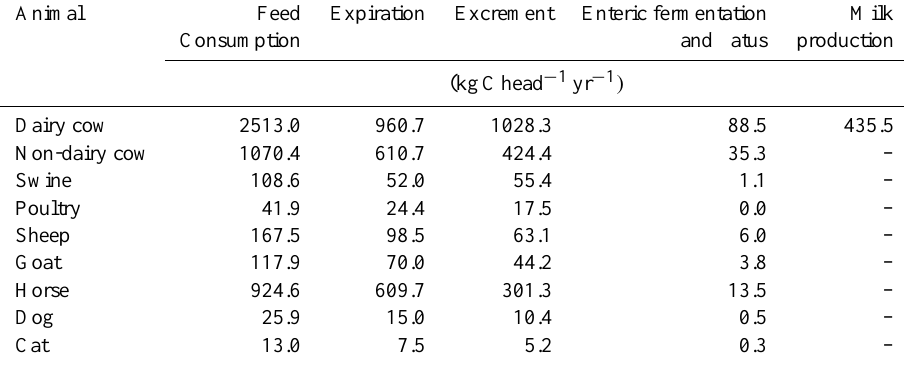
Animal Feed Expiration